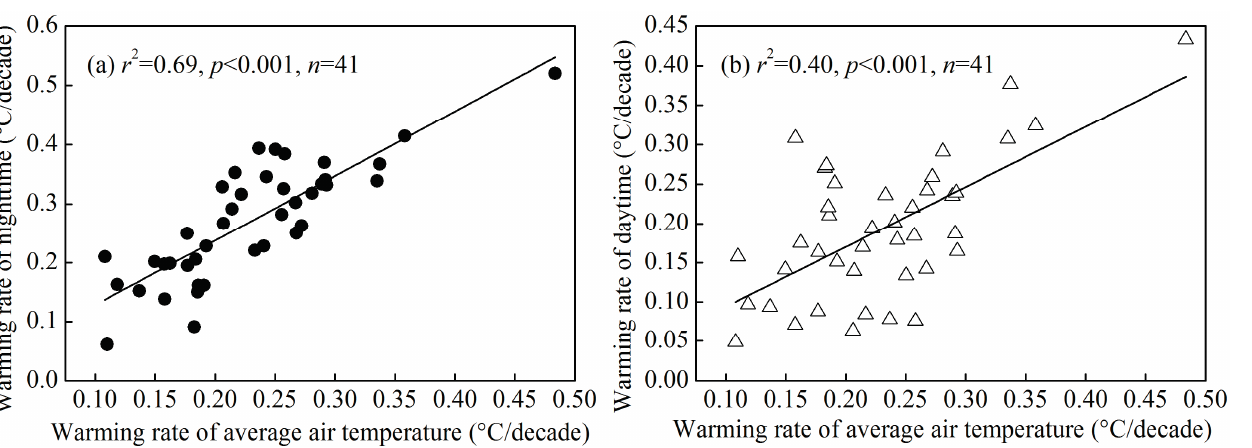
Figure 2. Significant linear relationship between the warming rates of average, minimal ( a ) and maximal ( b ) air temperature in in the